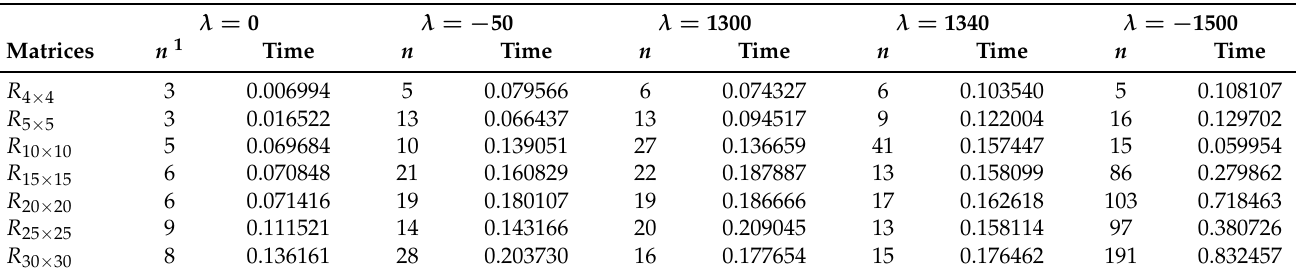
Table 3. Results of the